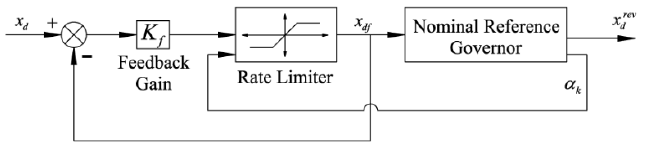
Figure 3. The schematic diagram of the smooth reference governor.